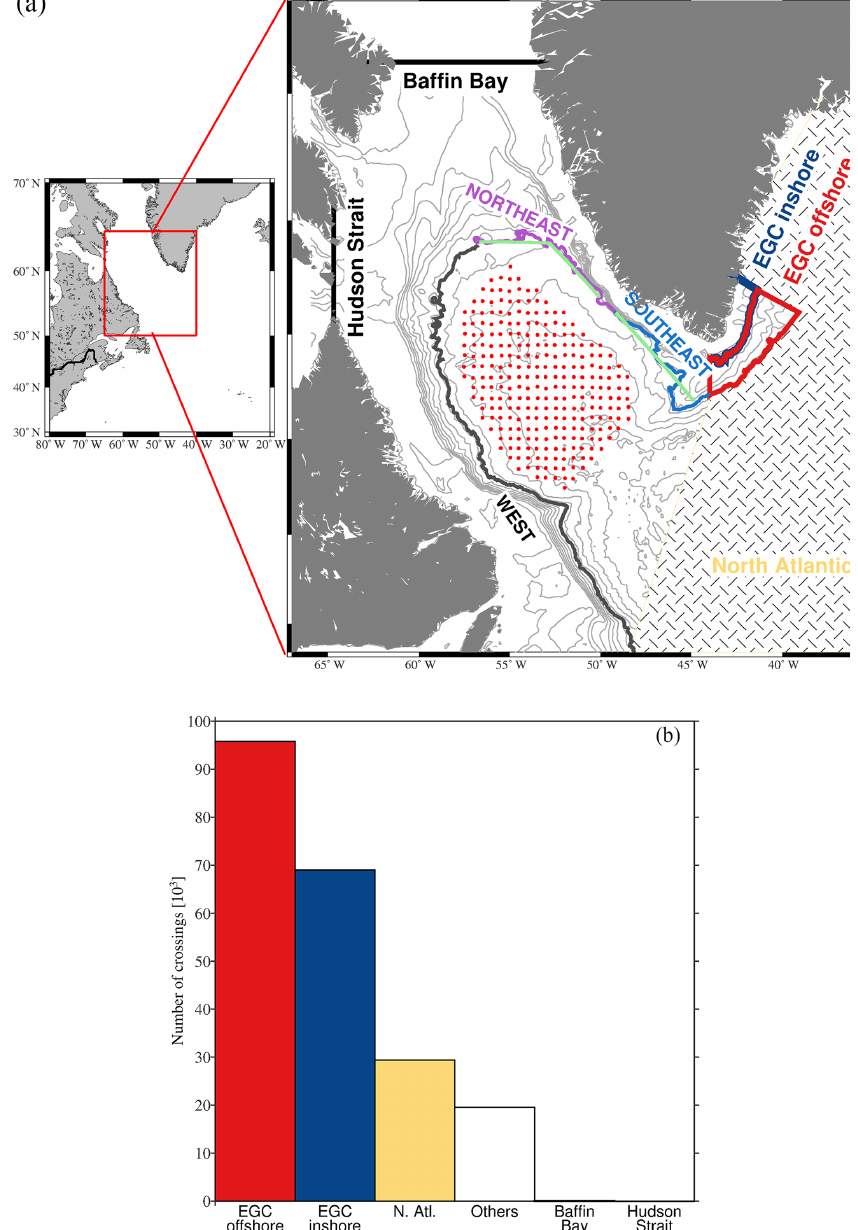
Figure 2. (a) The location of the Labrador Sea (left) and a zoomed-in view of the Labrador Sea on the right. The topography is shown in gray contours, spaced in 500m intervals. The thick contour shows the 2500m isobath and is referred to as the boundary between shelf and basin in the text. The areas referred to in the study as southeast and northeast are shown in blue and purple, respectively. Red dots denote the release positions of the particles in this study. The five regions referred to as the origin of water are also shown here. The East Greenland Current (EGC) inshore and offshore region are shown as the blue and red box, respectively. Baffin Bay and Hudson Strait are shown as black sections and the North Atlantic region as the yellow line and structured region. (b) The number of crossings per origin. East Greenland offshore (red), East Greenland inshore (blue), other regions in the North Atlantic (yellow), unidentified origins (no color), Baffin Bay and Hudson Strait (black). The light green sections show the sections across which Ekman transport is